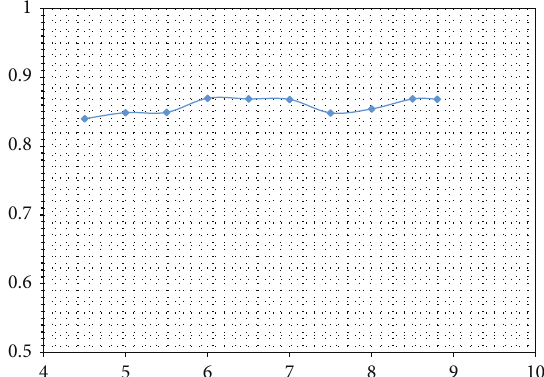
Figure 12: Aperture efficiency using the measured data of final feed standing in a fixed position in the antenna. The focal point of the antenna is at 660 mm from the feed